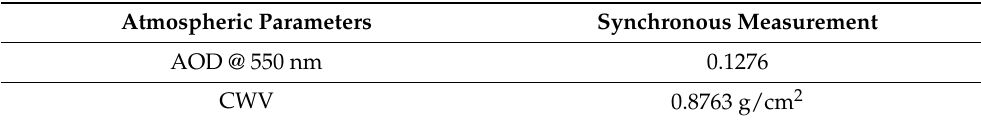
Figure 8. The measurement of atmospheric parameter of AERONET Baotou site. Table 3. Synchronous measurement of atmospheric parameters.